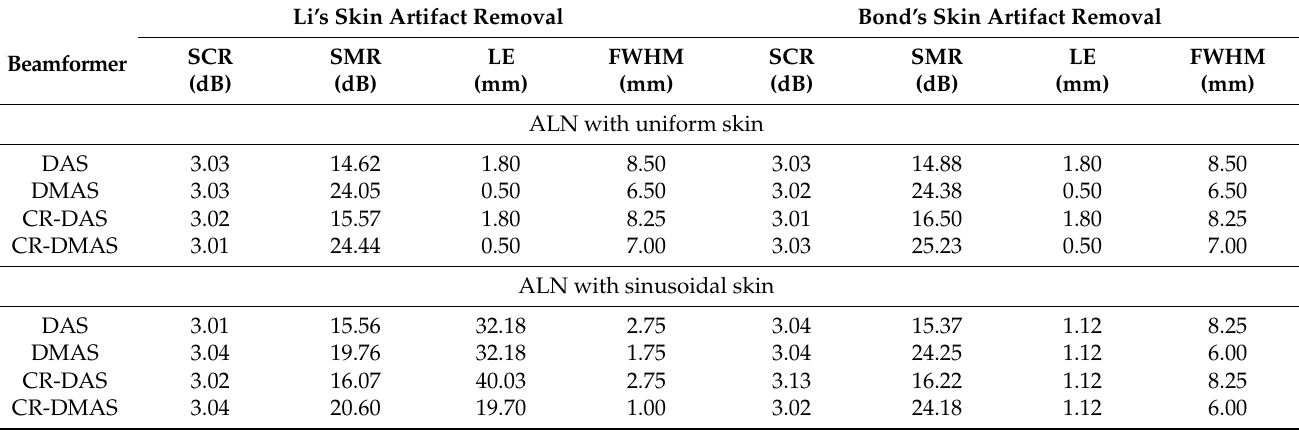
Table 2. Performance metrics of all the beamformers using Li’s and Bond’s skin artifact removal algorithms for one ALN with uniform skin